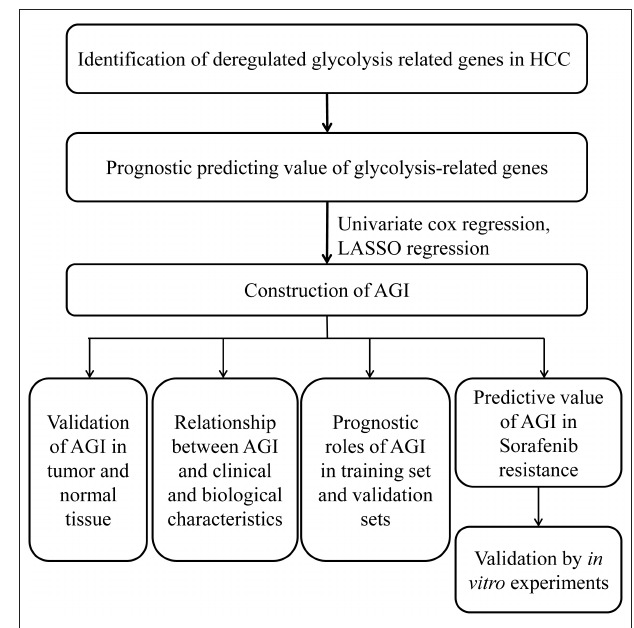
FIGURE 1 | Flowchart presenting the establishment and validation of the gene signature.